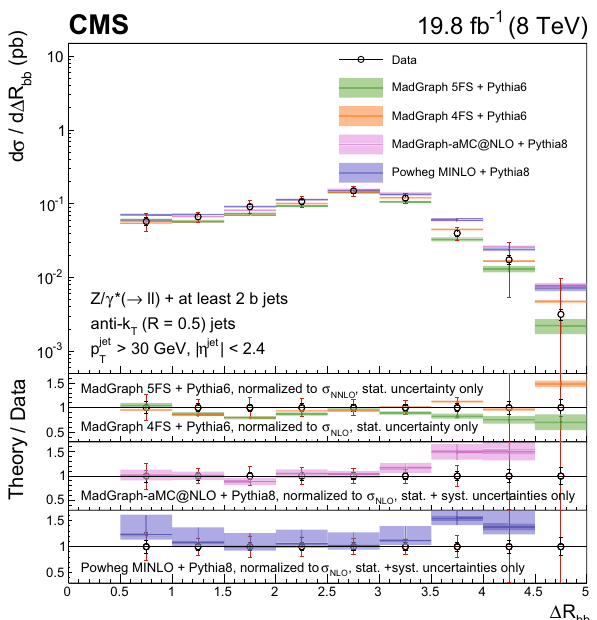
Fig. 16 Differential fiducial cross section for Z(2b) production as a function of Δ R min , compared with the MadGraph 5FS, MadGraph Zb 4FS, MadGraph5 _a MC@NLO , and powheg minlo theoretical pre- dictions ( shaded bands ), normalized to the theoretical cross sections describedinthetext.Foreachdatapointthestatisticalandthetotal(sum in quadrature of statistical and systematic) uncertainties are represented by the double error bar . The width of the shaded bands represents the uncertainty in the theoretical predictions, and, for NLO calculations, theoretical systematic uncertainties are added in the ratio plots with the inner darker area representing the statistical component